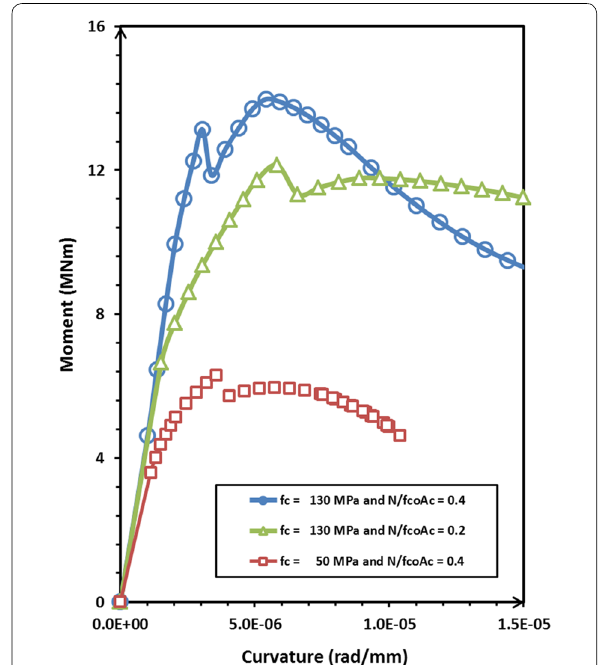
Fig. 5 Higher plastic energy in VHSC columns relative to NSC